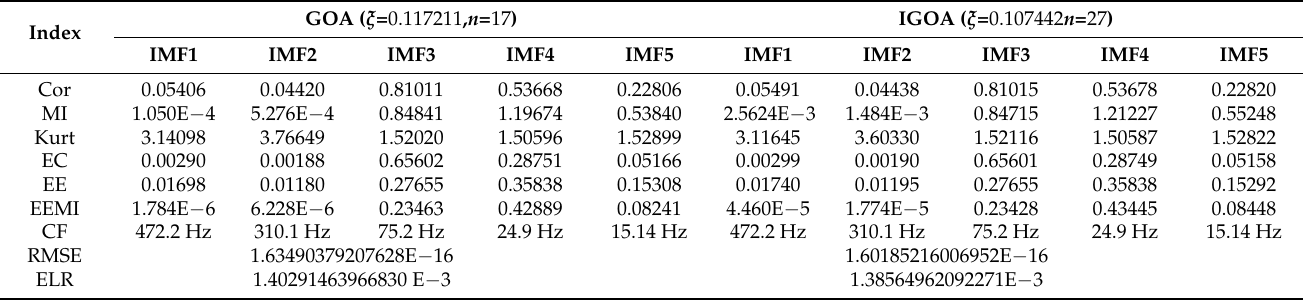
Table 7. Decomposition results evaluation of simulated signal y ( t ) under different parameters.